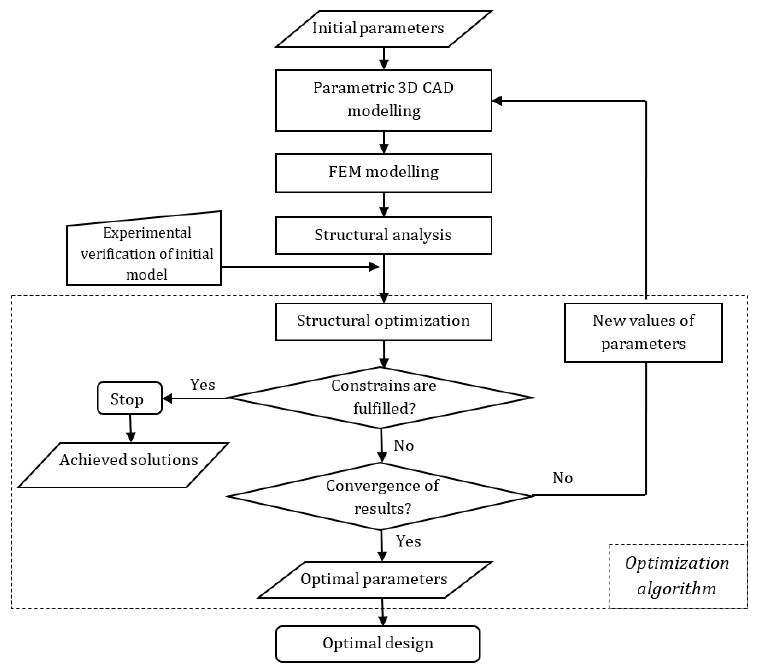
Figure 13. Algorithm of developed KBE system.